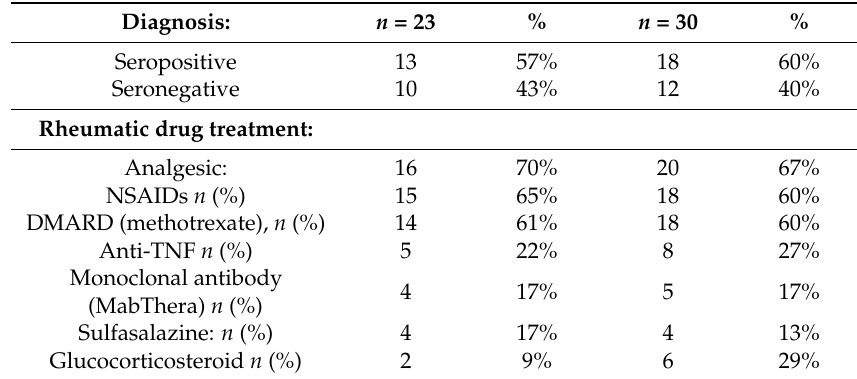
Table 2. Diagnosis and rheumatic drug